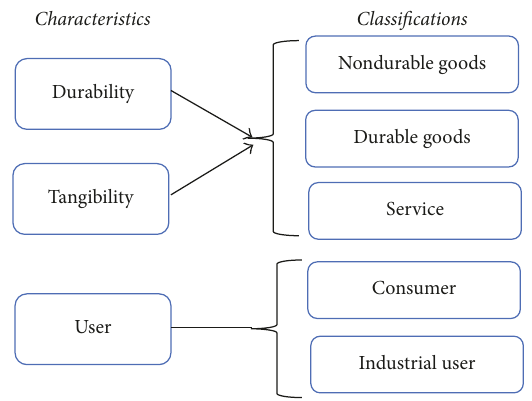
Figure 1: Kotler’s product classification system. Based on [18].